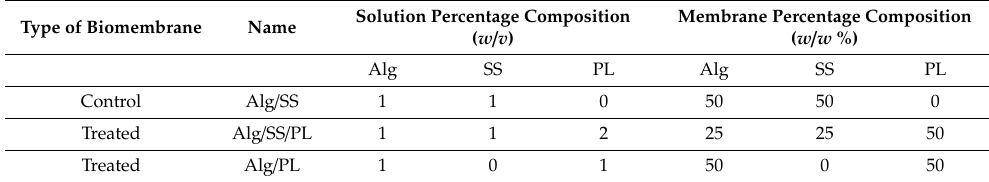
Table 1. Composition of the biomembranes. Biomembranes percentage composition ( w / v ) of